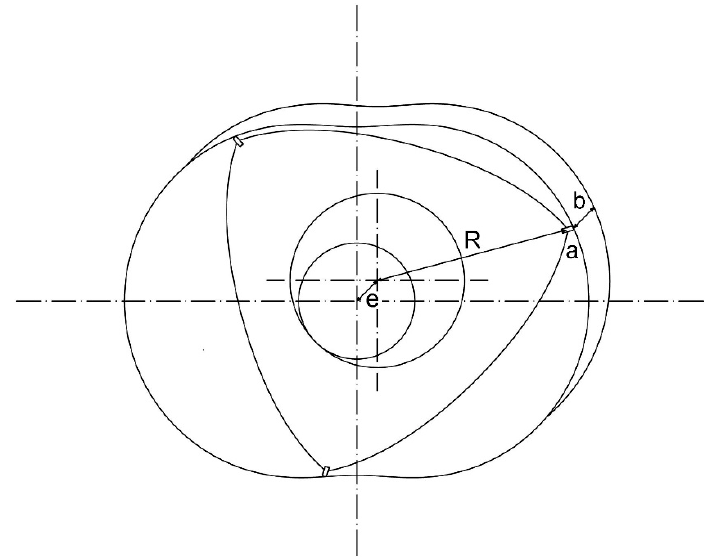
Figure 3. Wankel engine geometry (e: Eccentricity, R: Generating radius, a: Equidistance, b: Width).